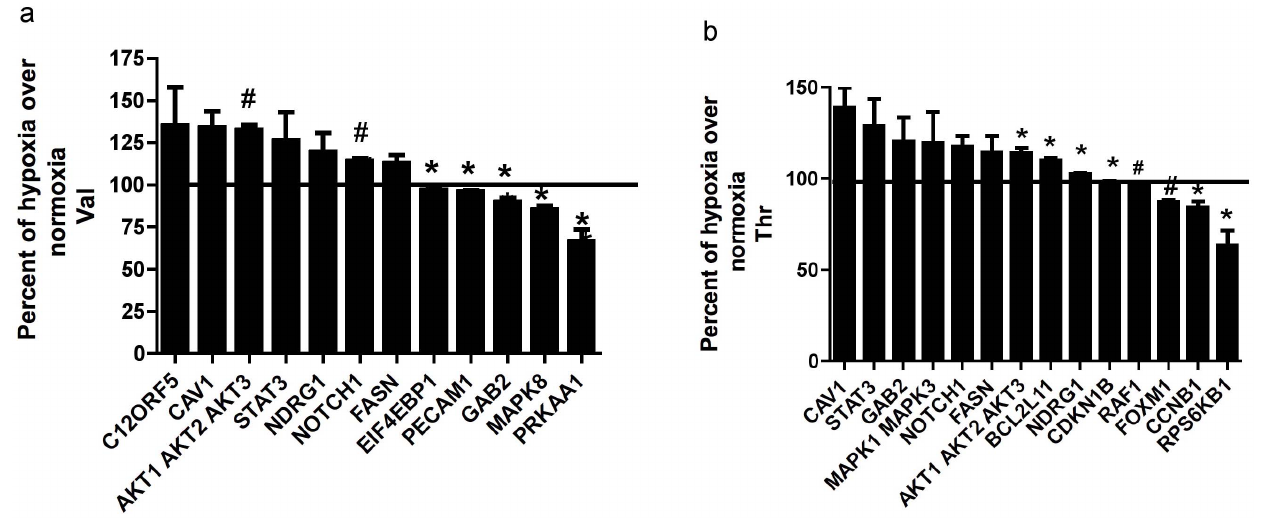
Figure 3. Impact of normoxia on polar or branched chain amino acid stimulated BMMSCs. Reverse-phase protein array graphs of two sets of BMMSCs grown under normoxic conditions (21% O 2 /5% CO 2 ) and under low O 2 tension (3% O 2 /5% CO 2 ; physiologic hypoxia). When cells were 80% confluent,The cells were treated with Val or Thr (100 m M) in serum-free media for 3 h. The cells were washed twice with PBS and lysis buffer was added to the plates. a-Val and b-Thr. Results are expressed as means 6 SEM for three independent experiments. * p # 0.05 and # p # 0.01. Percent change of hypoxia over control for Val was determined as percent change of BMMSCs treated with Val under hypoxic conditions (3% O 2 %) vs. BMMSCs treated with Val under normoxic conditions (21% O 2 ) (control=100%). Both sets of BMMSCs were treated with Val and grown under different oxygen levels. Same for Thr panel. CAV1: Caveolin 1 (Caveolin-1-R-V). NDRG1: N-myc downregulated gene (NDRG1_pT346-R-V). AKT1 AKT2 AKT3: protein kinase B (Akt_pT308-R-V). STAT3: Signal transducer and activator of transcription 3 (STAT3_pY705-R-V). NOTCH1: Notch homolog 1 (Notch1-R-V). FASN: Fatty acid synthase (FASN-R-V). PECAM1: Platelet endothelial cell adhesion molecule (CD31-M-V). GAB2: GRB2-associated-binding protein 2 (Gab2-R-V). PRKAA1: 5’-AMP-activated protein kinase catalytic subunit alpha-1 (AMPK_pT172-R-V). MAPK1 MAPK3: Mitogen-activated protein kinase (MAPK_pT202_Y204-R-V). CDKN1B: Cyclin-dependent kinase inhibitor 1B (p27-R-V). RAF1: Proto-oncogene serine/threonine-protein kinase (C-Raf-R-V). FOXM1: Fork-head box protein M1 (FoxM1-R-V). CCNB1: Cyclin B1 (Cyclin_B1-R-V). RPS6KB1: Ribosomal protein S6 kinase